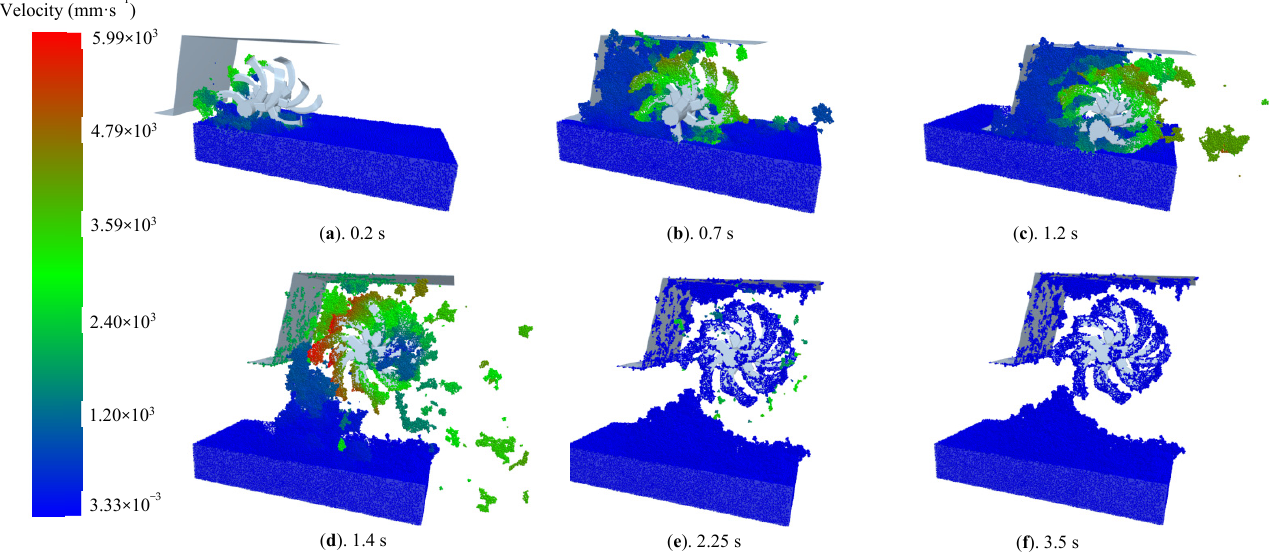
Figure 7. The process of rotary tillage. ( a ) 0.2 s ( b ) 0.7 s ( c ) 1.2 s ( d ) 1.4 s ( e ) 2.25 s ( f ) 3.5 s.